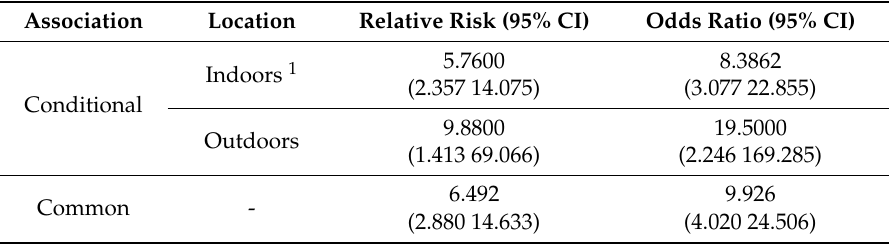
Table 3. The Relative risk, odds ratio, and 95% confidence interval comparing the situations without dogs around to those with dogs around, n =